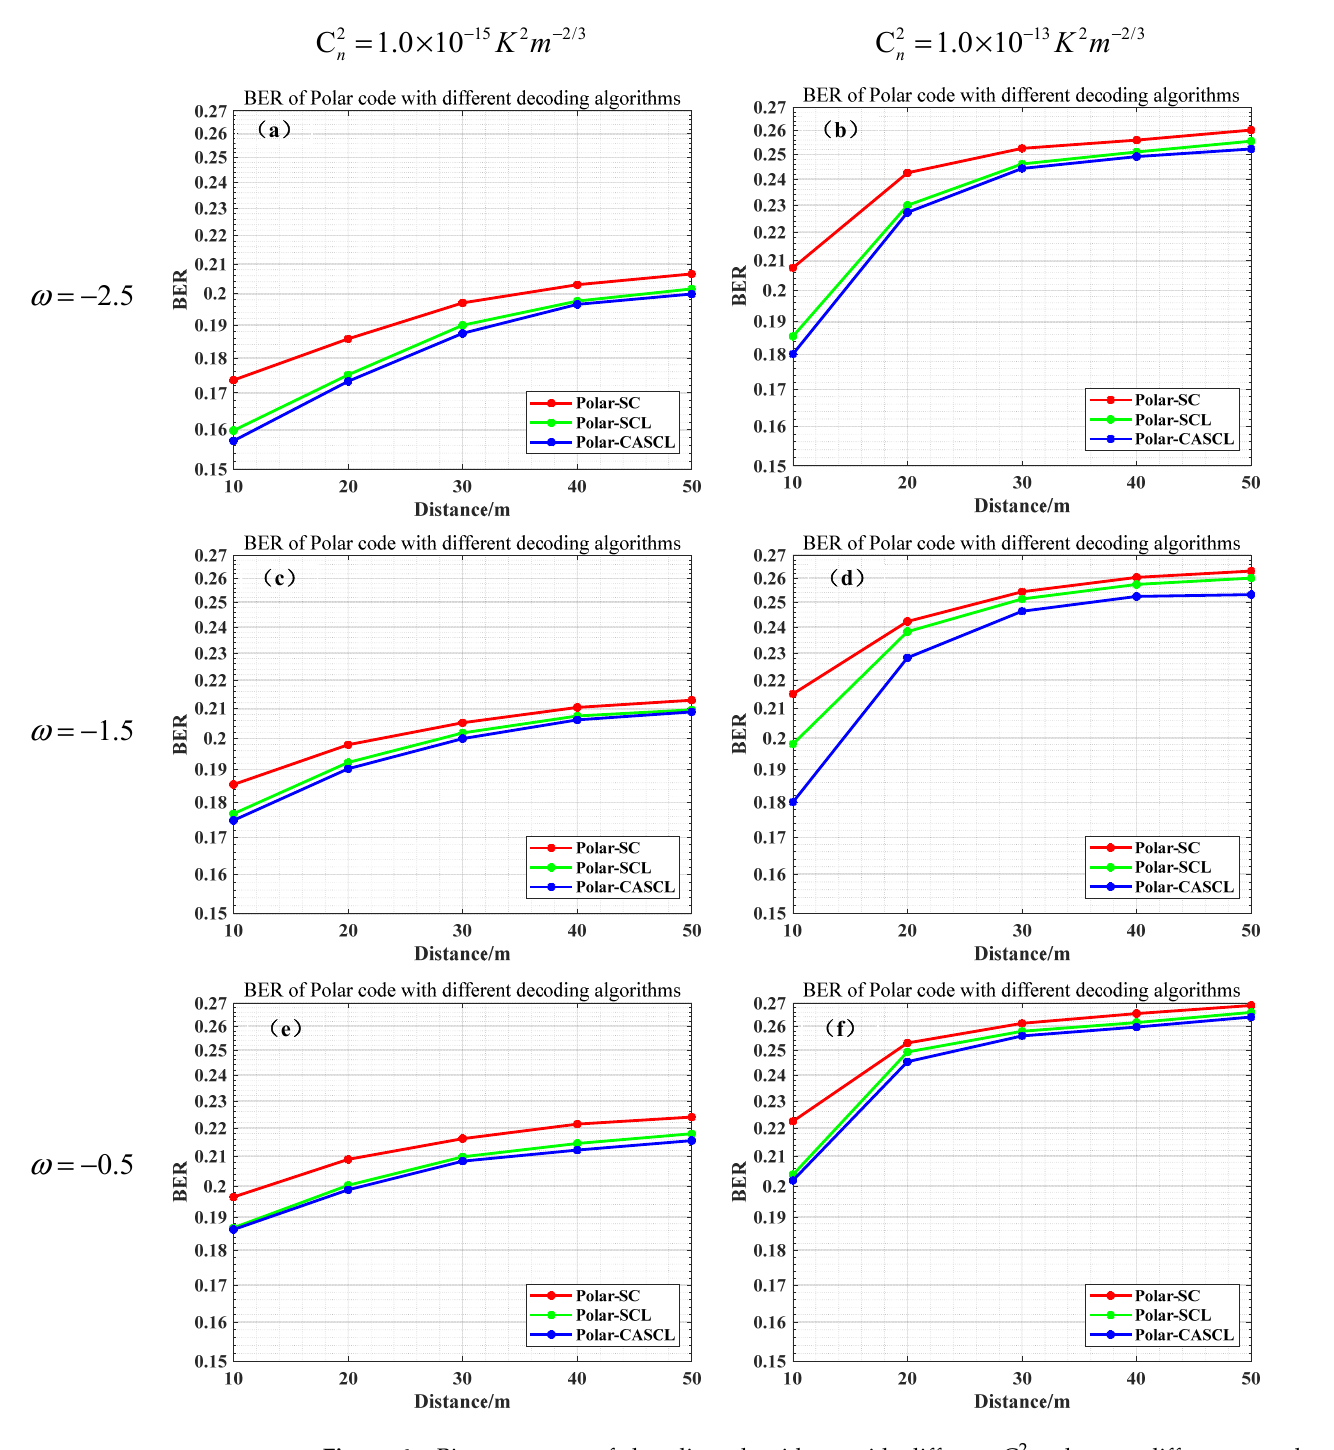
Figure 6. Bit error rates of decoding algorithms with different 2 C